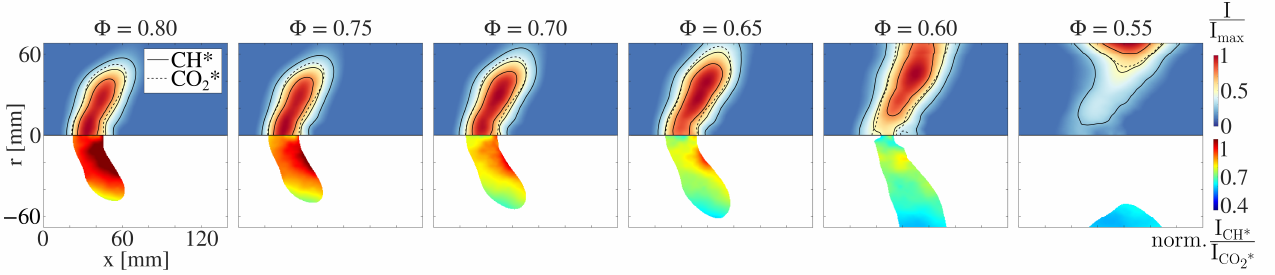
Figure 6. ( Upper half: ) Locally resolved CH* chemiluminescence intensity for natural gas combustion at an air mass flow rate of ˙m air =25g/s. The solid black lines represent the 75%, 50% and 25% isolines of the chemiluminescence intensity. The dashed black line represents the 50% isoline of the corresponding CO 2 * chemiluminescence intensity. ( Lower half: ) Locally resolved CH*/CO 2 * distribution. The values are normalized to the mean CH*/CO 2 * ratio at Φ